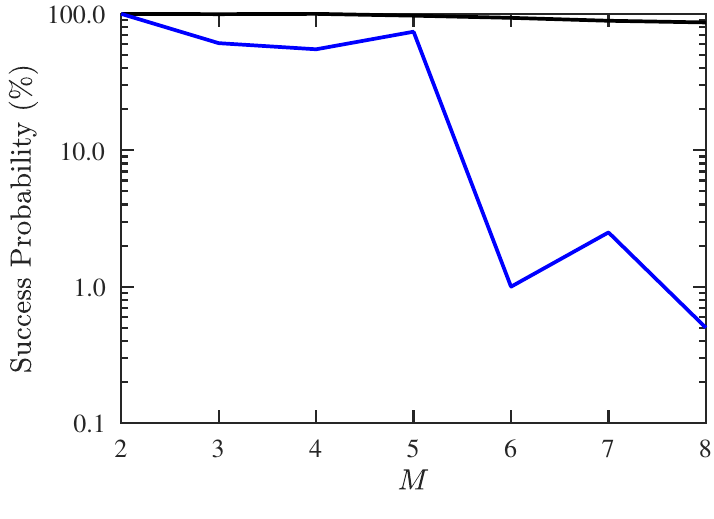
Figure 3. Success probability of DOA and CF estimation under different numbers of signals, SNR = 10 dB, Q = 300, M u = 1. ———: proposed PJE algorithm, ———: conventional JE algorithm.